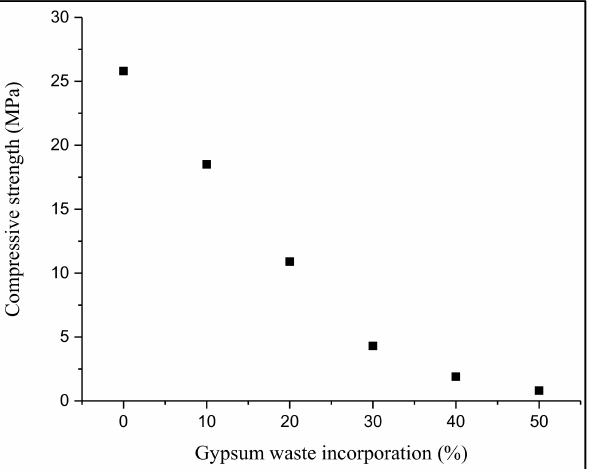
Figure 5. Effect of gypsum waste utilization on the compressive strength of fired clay